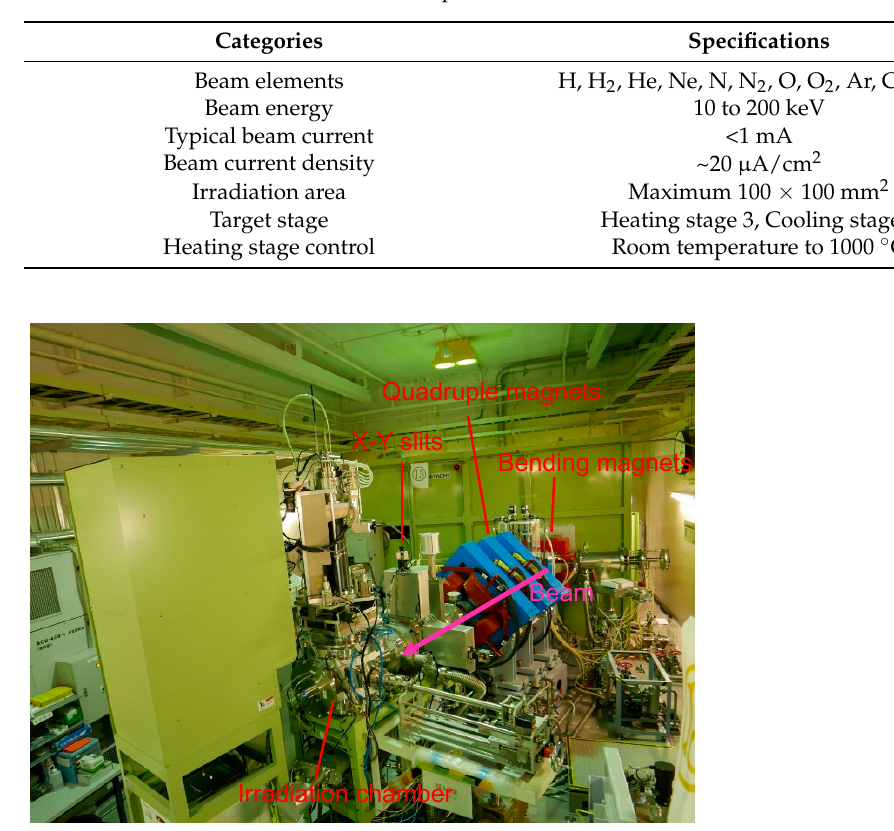
Table 3. Performance of the 200 kV ion-implanter.